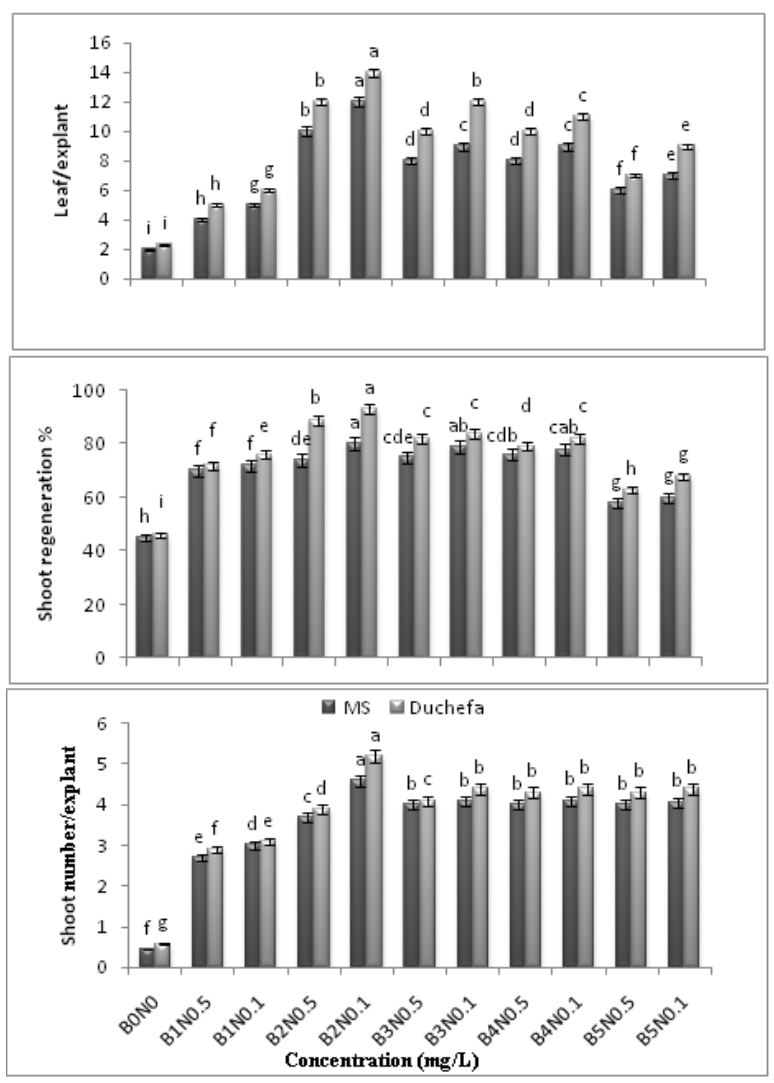
Figure 3. Effects of BAP and NAA concentrations in MS and Duchefa semi-solid media on number of shoots per explant, number of explants responding to form shoot and leaf per explant in C.asiatica (BAP = B, NAA = N, MS = Murashige and Skoog, Duchefa = Duchefa shoot media n = 4 (Example: B2N0.1 = BAP 2 mg/L and NAA 0.1